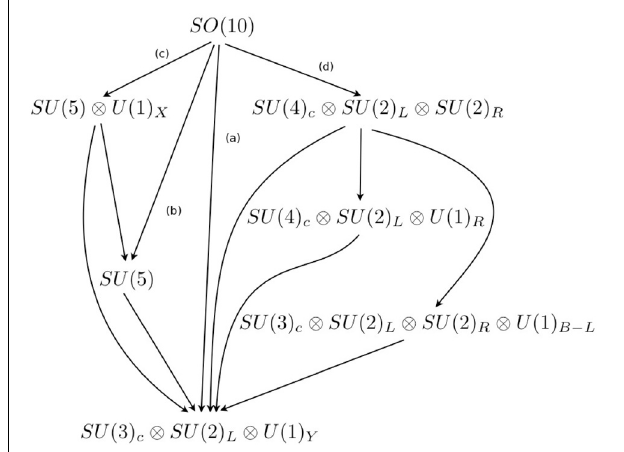
FIGURE 1 | Patterns of symmetry breaking from SO(10) to the Standard Model gauge